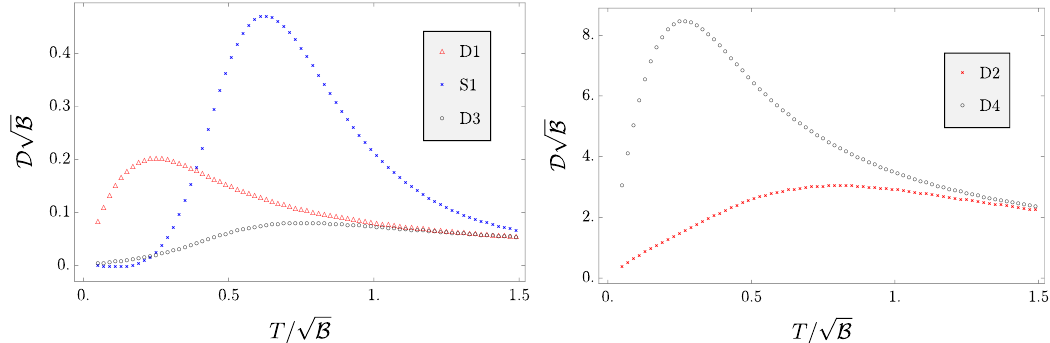
Figure 10 . Plots of the four di(cid:11)usion constants (D1, D2, D3, D4) and the sound attenuation (S1) p as a function of T= B at (cid:18) = (cid:25)= 2. Black, red and blue curves depict dissipative coe(cid:14)cients that originate from the Alfv(cid:19)en, slow magnetosonic and fast magnetosonic waves, respectively. (cid:25)= 2. Both V and the di(cid:11)usion constant of D3, D , strongly depend on (cid:22) (cid:11) . For a small A D 3 variation in the values of (cid:22) (cid:11) , we plot the results in (cid:12)gure 11. 22 To show the importance